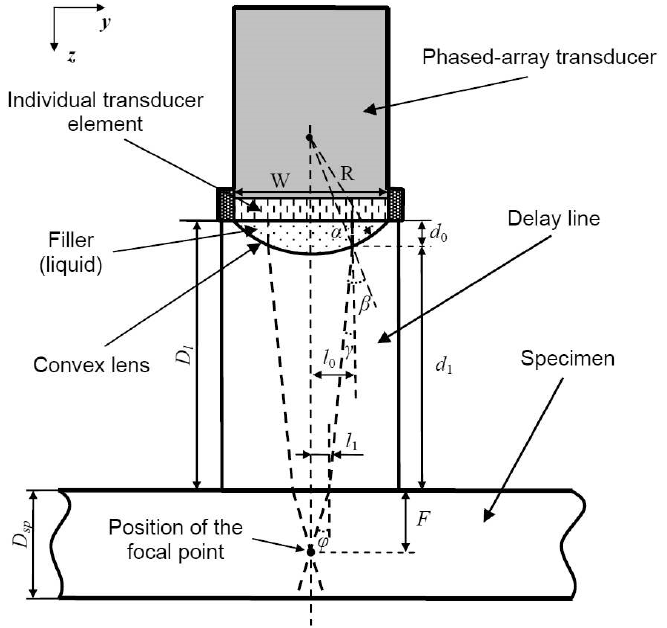
Figure 2. Calculation of the position of the defined point ( F ) of focusing inside the sample (having thickness of D sp ).